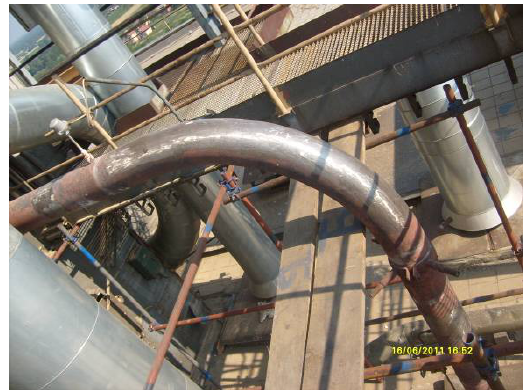
Figure 1: Part of the steam line during